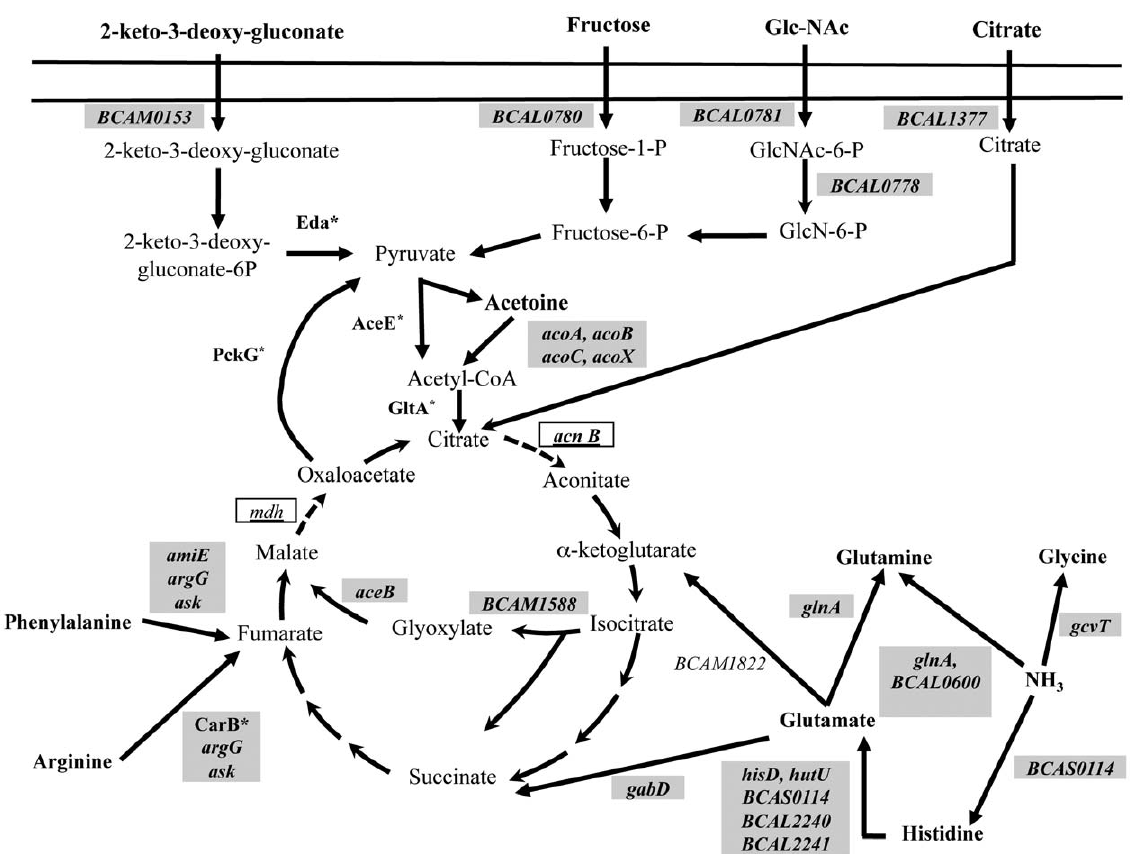
Figure 4. Genes differently transcribed in IST439 and IST4113 related with the uptake and metabolism of carbohydrates and amino acids, shown associated to the metabolic pathways in which they are involved. The metabolic map shown was prepared based on the information available in the KEGG Pathways Database and using as the input dataset the genes clustered in the functional classes shown in Fig. 1 ‘‘Transport’’, ‘‘Amino acid metabolism’’ and ‘‘Carbohydrate Metabolism’’. The genes that are more actively transcribed in IST4113 are shown inside grey boxes whereas the genes that have a higher transcript level in the IST439 variant are indicated inside white boxes. Proteins known to be more abundant in IST4113 than in IST439, based on the results of a previous expression proteomic analysis [16], are marked with an